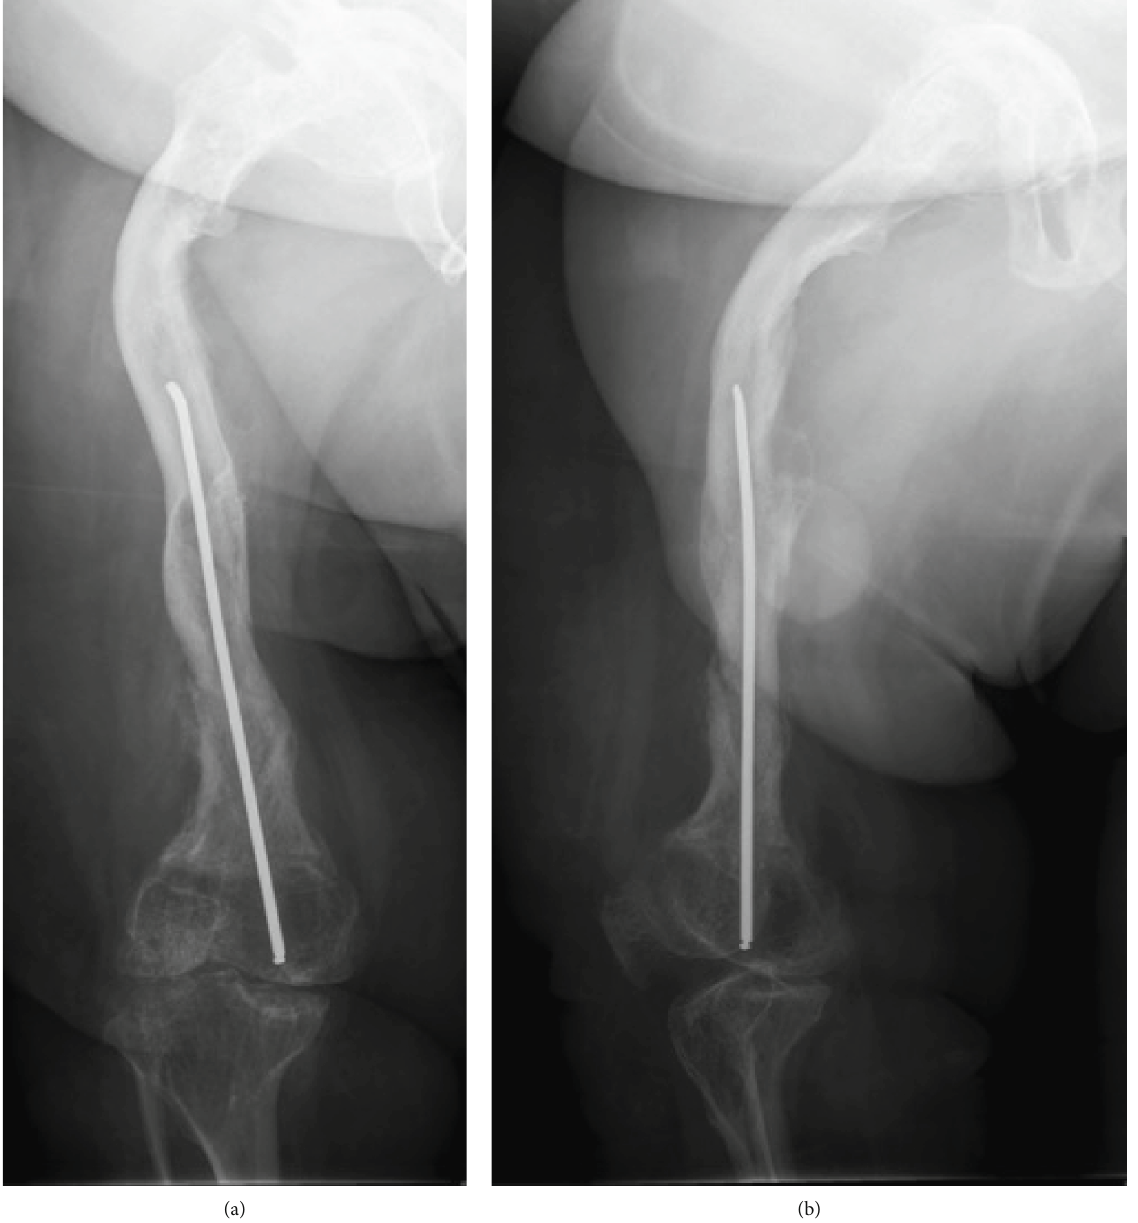
Figure 6: Bony healing 6 weeks after conservative treatment of the peri-implant fracture. (a) Anteroposterior view. The fracture is almost not visible anymore. (b) Lateral view. Callus tissue indicates the healing process of the bone. A gap can be seen, so we developed a scheme for the gradual increase of weight